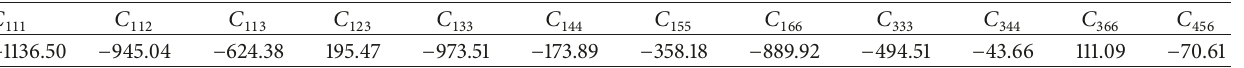
Table 4: Third-order elastic constants (𝐶 𝑖𝑗𝑘 ) of tetragonal YNi 2 B 2 C (in GPa).